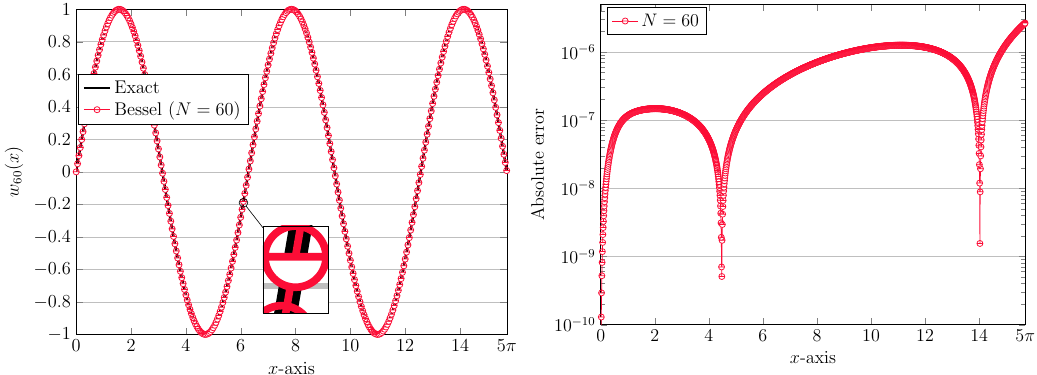
Figure 5. The comparison of numerical and exact solutions ( left ) and the resulting absolute error ( right ) using N = 60 and (cid:96) = 5 π in Example